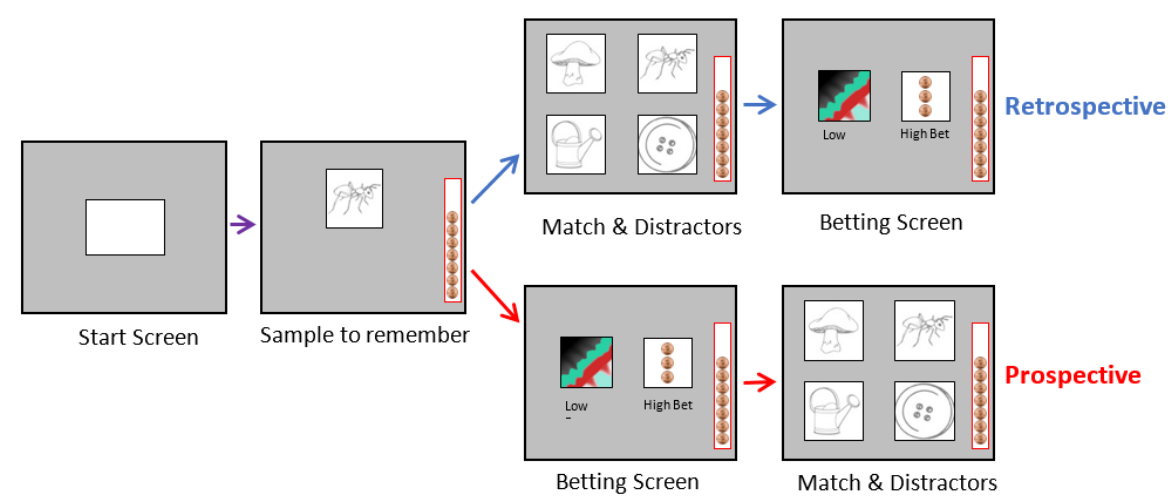
Figure 1. Trial protocol for retrospective and prospective conditions. The trial starts with a start button, followed by the sample image. In the retrospective condition subjects are then shown a screen with four images: one target and three distractors. After choosing one of these the subject is taken to the betting screen. In the prospective condition, the betting screen is presented directly after the sample, and the subject is shown the target and distractors after making a